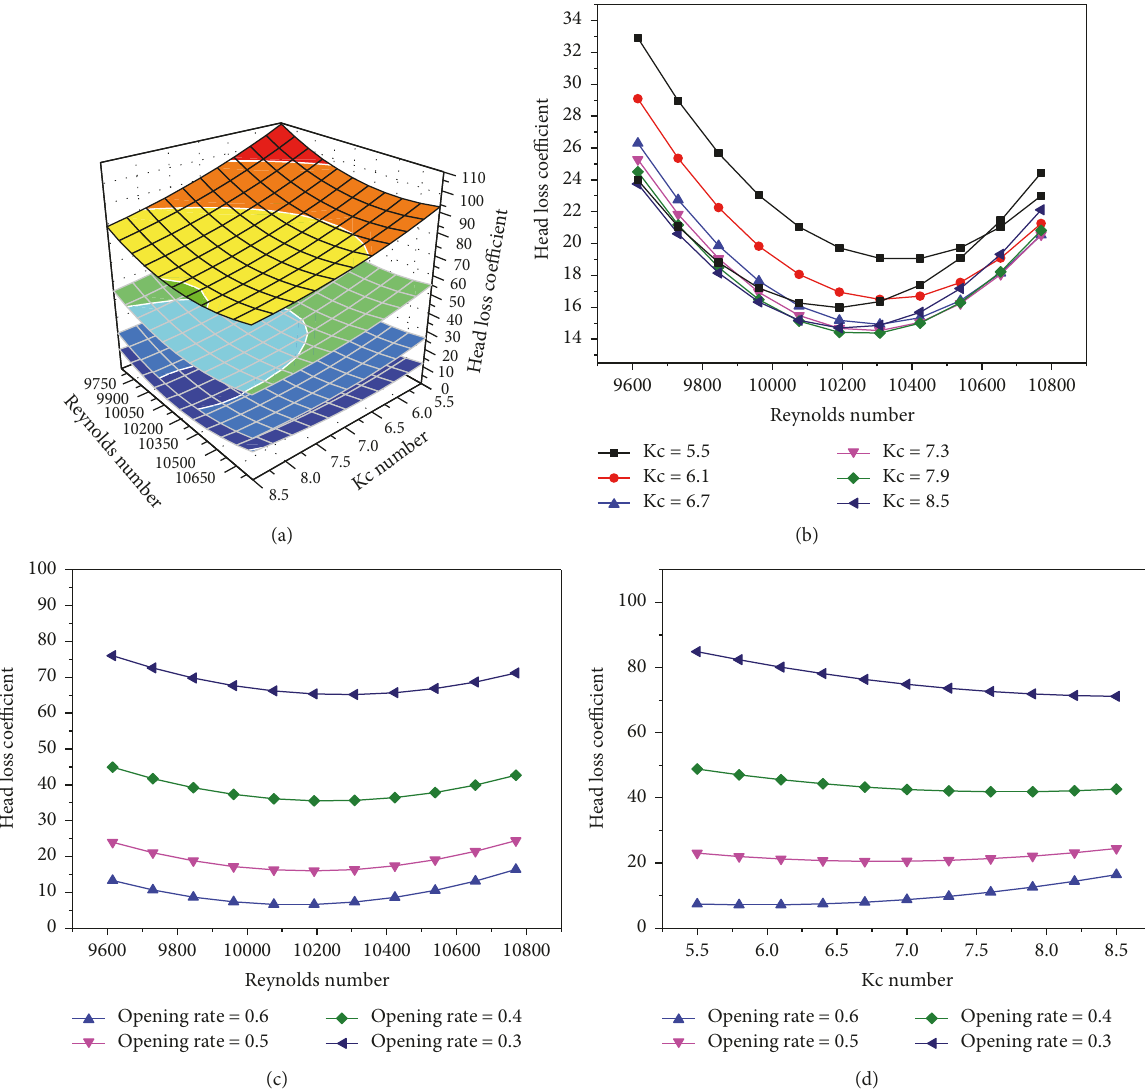
Figure 9: Relation schema of opening rate–Reynolds number–Kc